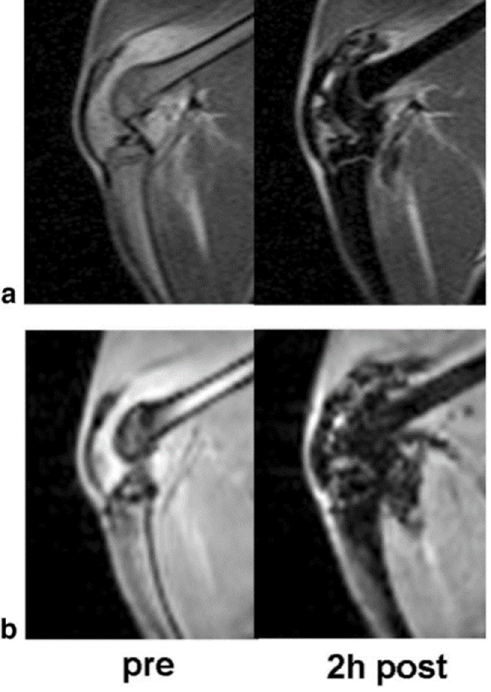
Figure 4. The T2 and T2* effect of ultra-small paramagnetic iron oxide nanoparticles: Corresponding T2-weighted ( a ) two-dimensional Spin Echo (SE) images and T2*-weighted ( b ) three-dimensional Spoiled Gradient Recalled Acquisition in the Steady State (SPGR) images of an arthritic knee joint before and two hours after injection. The USPIO results in hypointense regions with marked signal loss. Image taken with permission from Simon et al., 2006 [36].